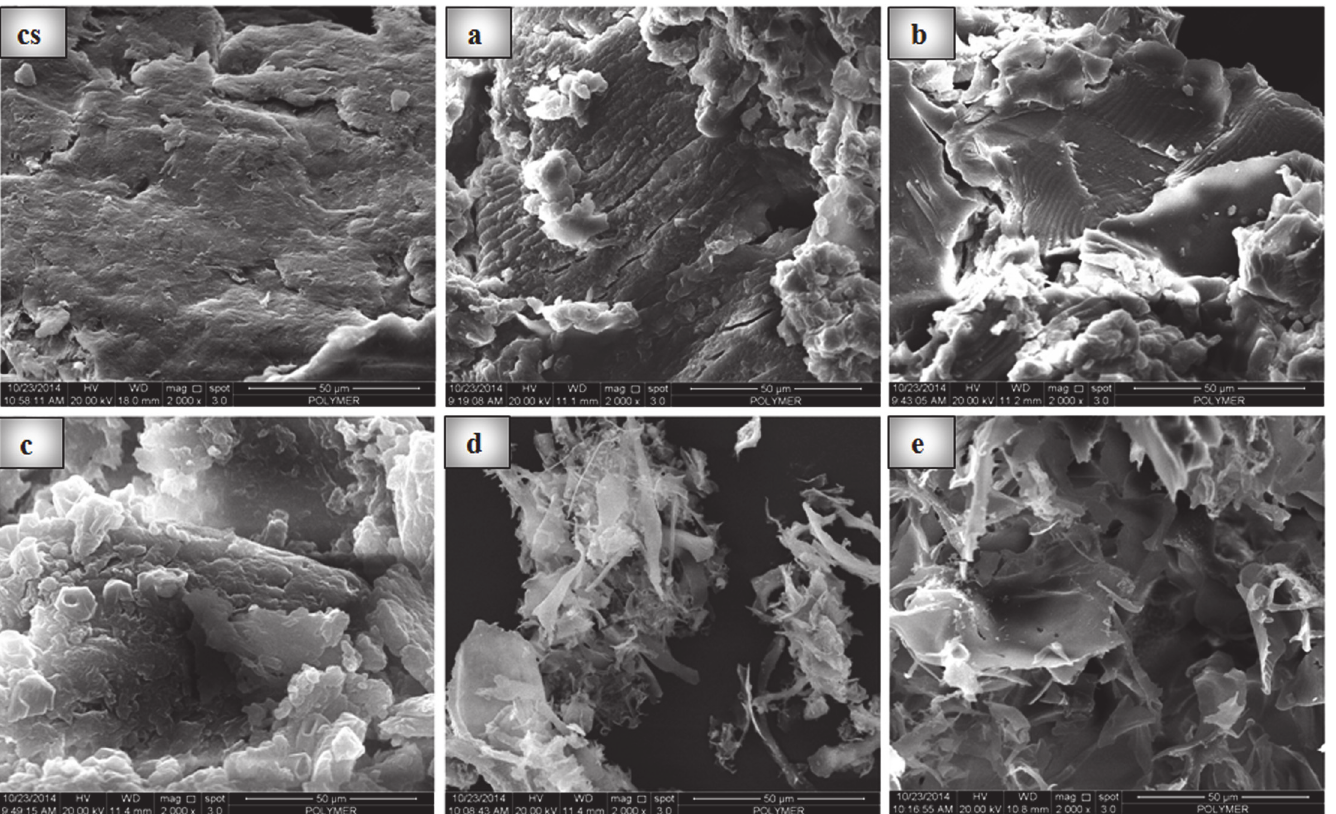
Fig 6. SEM images of chitosan and derivatives. Figure showing scanning electron micrographs (CS) chitosan(a) derivative 1, (b) derivative 2, (c) derivative 3, (d) derivative 4, and (e) derivative 5.